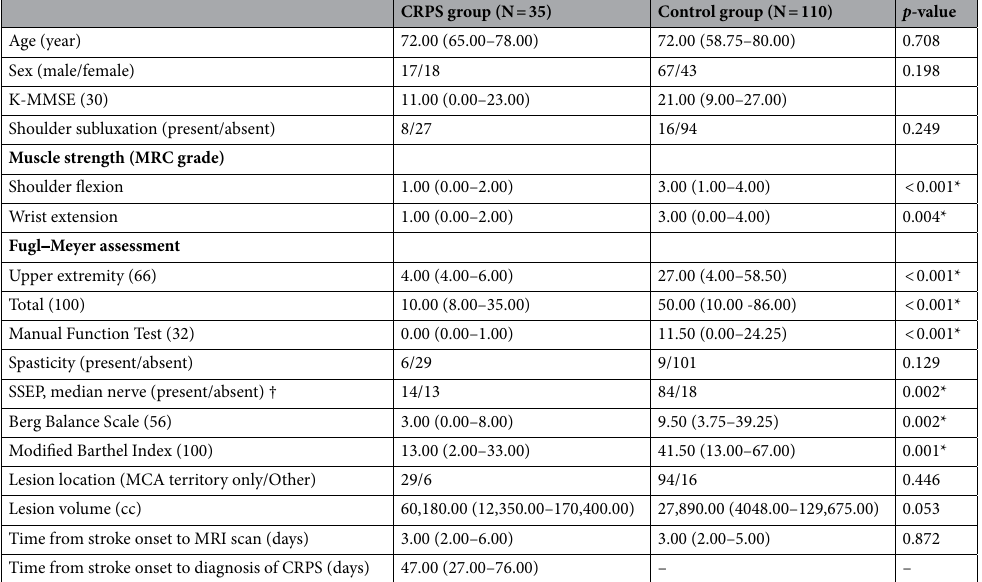
Table 1. General characteristics of subjects. All ordinary and continuous data were presented as median (interquartile range). Numbers in parenthesis are maximal score. MRC, Medical Research Council scale; SSEP, Somatosensory Evoked Potentials; K-MMSE, Korean version of the Mini Mental Status Exam; MCA, Middle Cerebral Artery. † Data were missing for 16